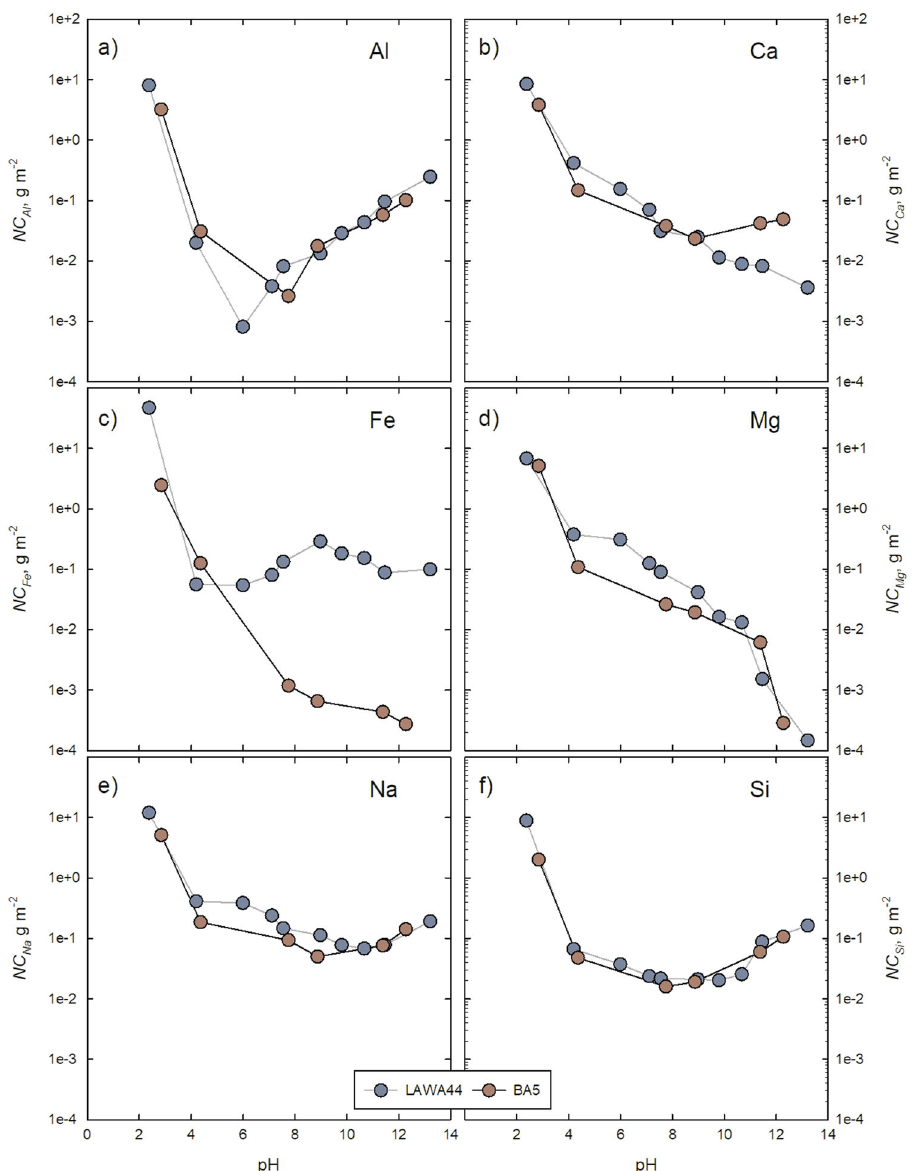
Fig. 9 Normalized release (NC i in g L − 1 ) for selected constituents as a function of fi nal extract pH from EPA Method 1313 testing of BA5 and LAWA44. a NC Al , ( b ) NC Ca , ( c ) NC Fe , ( d ) NC Mg , ( e ) NC Na , and ( f ) NC Si . The uncertainty (not shown) displayed in the plots is 14% of the value of NC i was calculated with Eq.